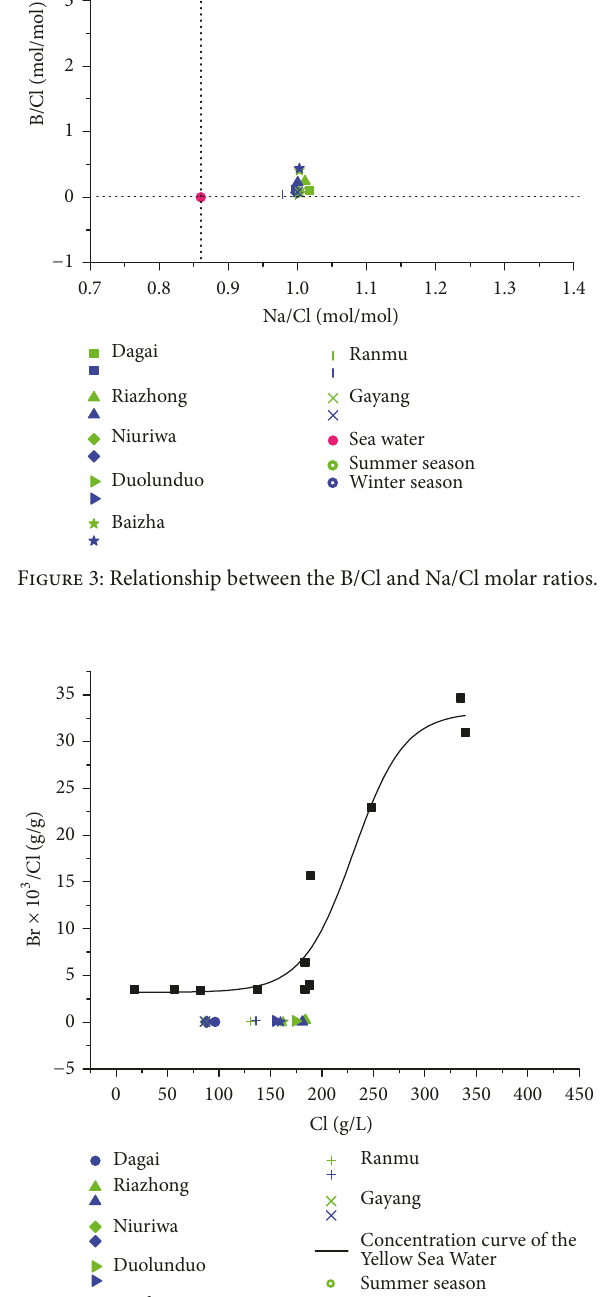
study area have low levels of bromide. Their maximum value is 42.2 ppm